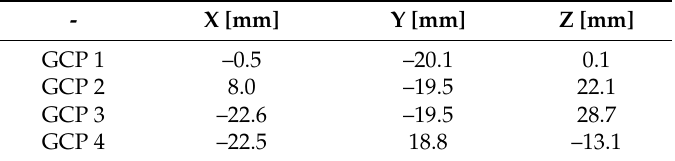
Table 2. Comparative assessment of UAV point cloud vs TLS point clouds—discrepancies at GCPs. - X [mm] Y [mm] GCP